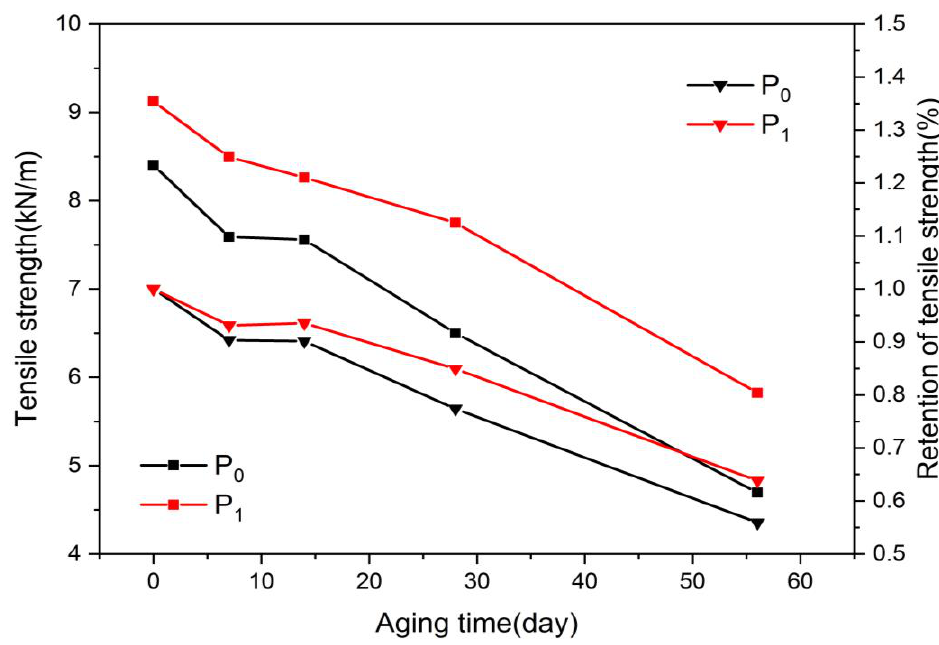
Figure 4. Variation of tensile strength with aging process.